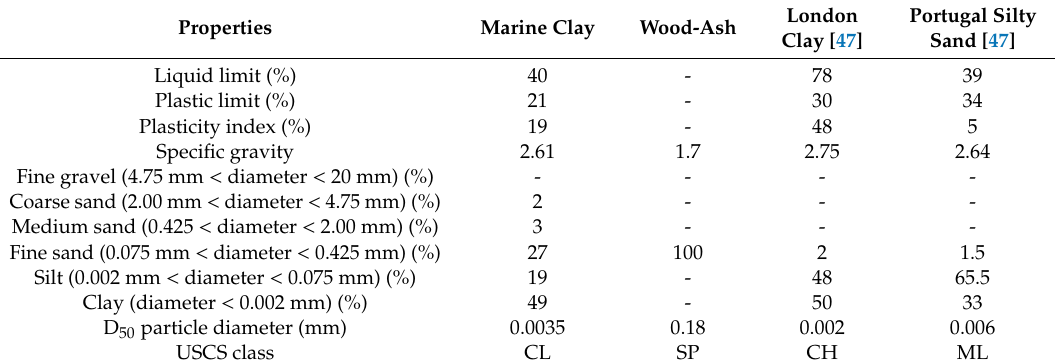
Figure 1. The grain Cumulative distribution (%) of studied marine deposited clay and wood-ash. Table 1. Physical properties of marine-deposited Clay, wood-ash, London clay, and Portugal silty sand.